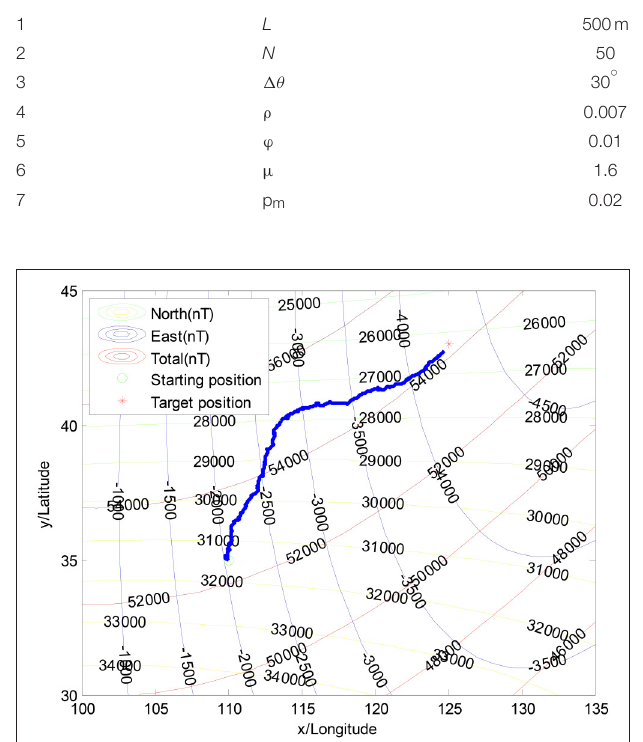
FIGURE 4 | The navigation without the geomagnetic anomalies.